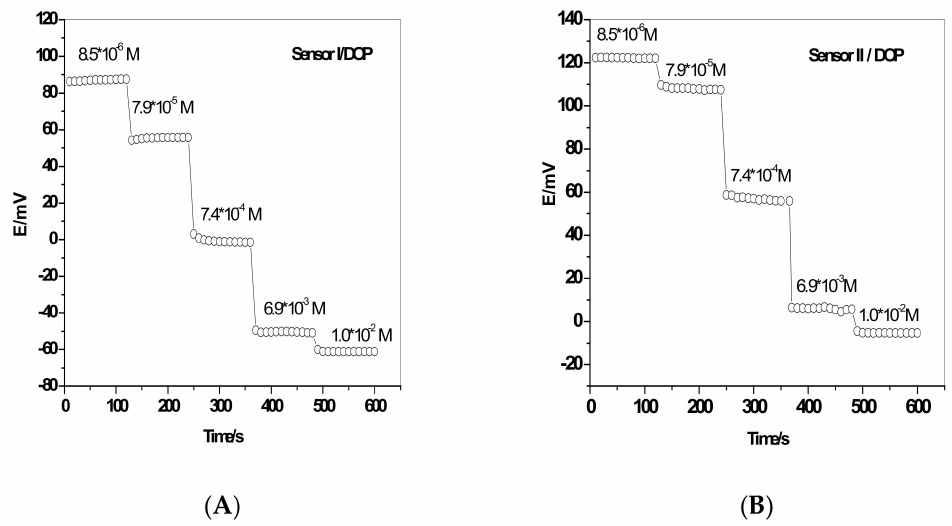
Figure 6. Responses of the proposed sensors using DOP as a plasticizer for ( A ) sensor I and ( B ) sensor